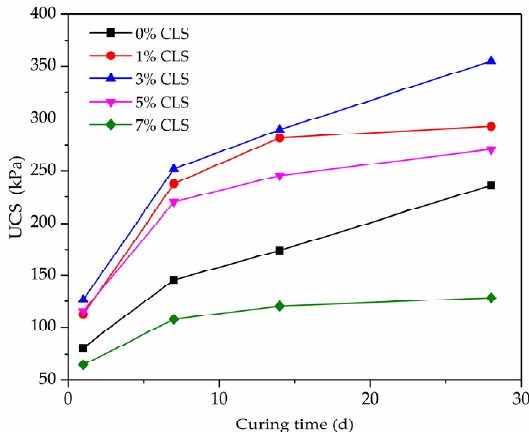
Figure 10. UCS of CLS improved